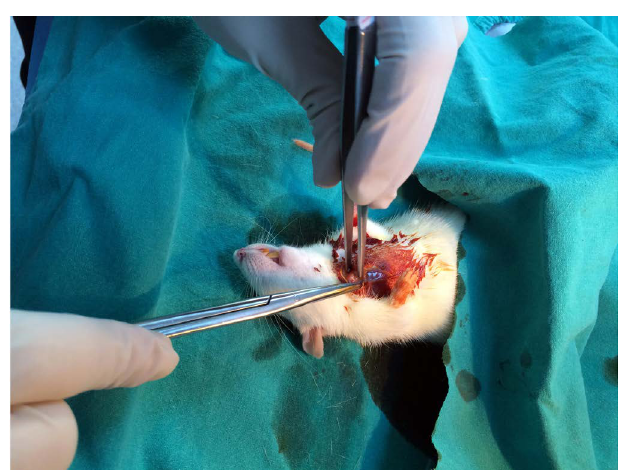
Fig. 2 - Removing of the upper